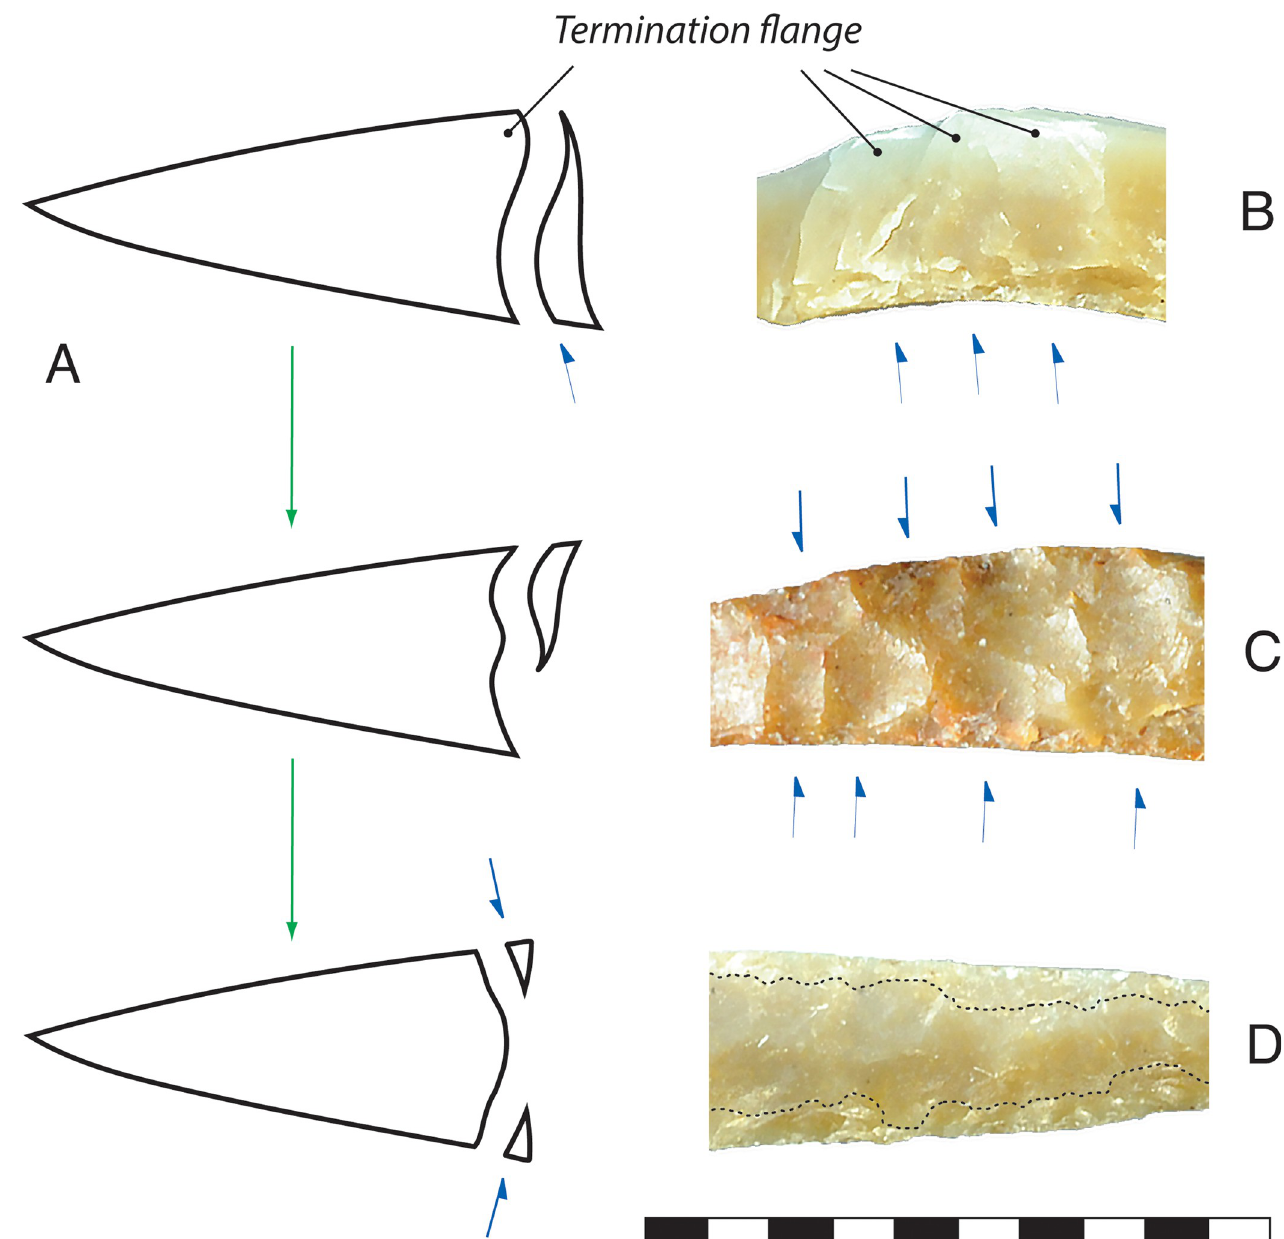
Fig 30. Late stage microlith backing method, Horizon IV, Saruq al-Hadid. (A) Schematic cross-section view of late stage microlith backing sequence. (A, top) Full-length backing flakes can create scars with a zone of high mass near the termination end, distal to the relatively deep negative bulb of percussion. This mass is referred to as the ‘termination flange’. (A, middle) The termination flange is removed by flakes struck from the opposite edge of the backed face, terminating near the middle. (D, bottom) The ‘overhang’ proximal to the percussion bulbs are removed by a non-invasive raking technique, enhancing the domed profile to the backed face. (B) Examples of termination flanges on 3 flake scars. The arrows indicate the directions of the principal flake removals. (C) Examples of flange removal scars, indicated by the top arrows, terminating near the middle of the backed face. (D) Example of a domed face enhanced by a raking technique, creating non-invasive scars. The dotted lines show the approximate limit of the raking scars. Scale bar 10 mm, for artefact D. From contexts 1794 (B, D) and 2009